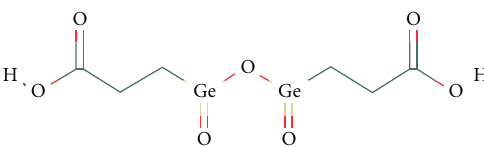
Figure 1: Structural formula of Ge-132